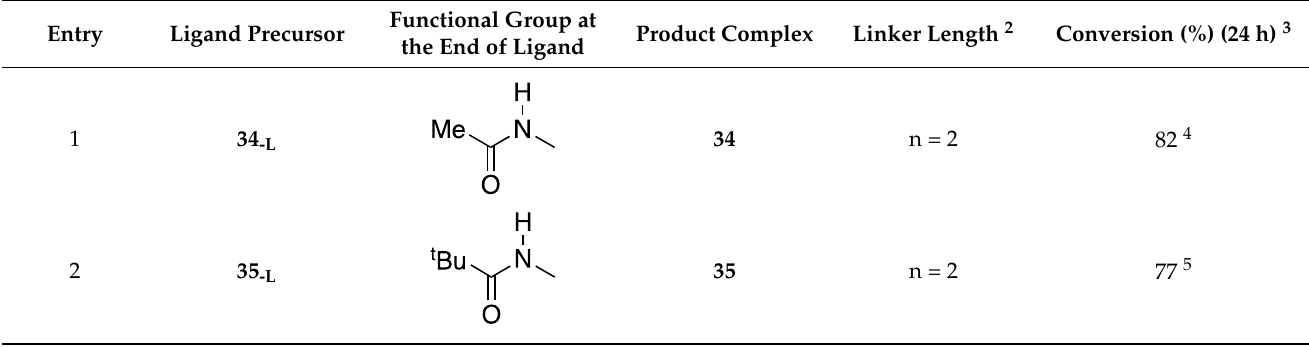
Table 4. Conversions of ligand exchange reactions between HG-II ( 5 ) and phenolic moiety-modified ligand precursors 1 [65] . Entry Ligand Precursor